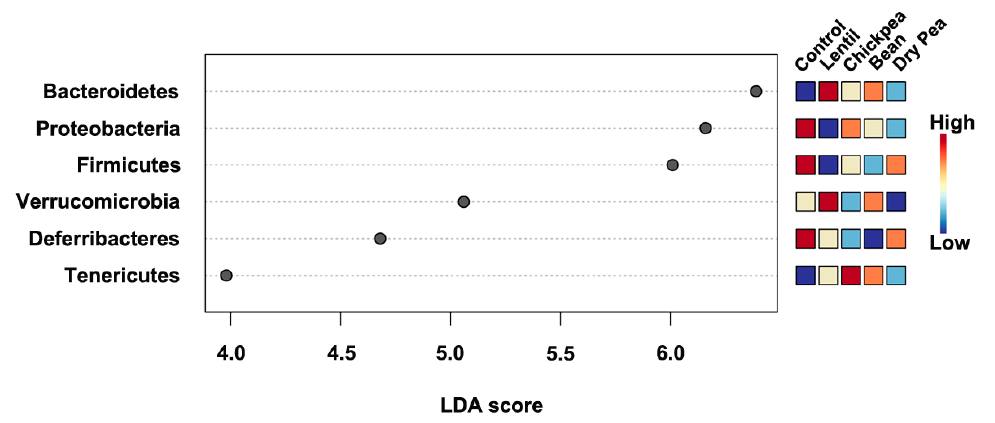
Figure 2. The linear discriminant analysis (LDA) of effect size (LEfSe) between the diet groups at the phylum level. All represented phyla were statistically significant (LDA score > |2.0|). Relative abundance per diet group is represented on the heatmap to the right.